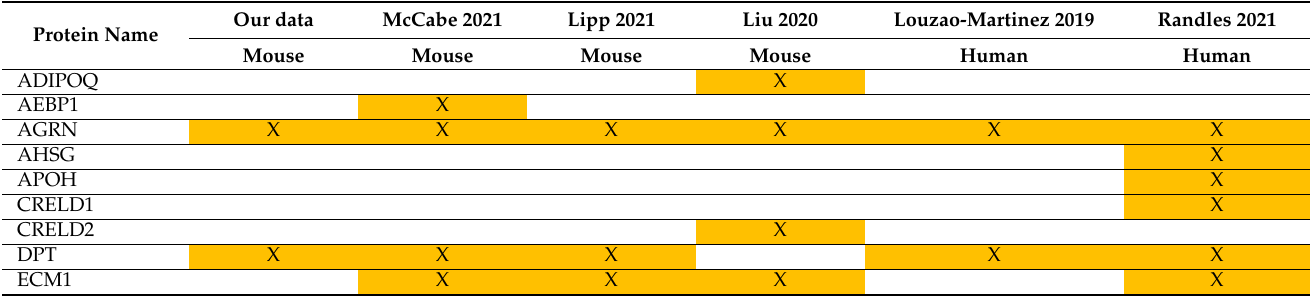
Table A11. The combined list of core matrisome proteins belonging to the category of ECM glycopro- teins and identified in mouse and human kidneys. The mouse matrisome proteins were obtained from our data and extracted from references [20,28,30]. Human matrisome proteins were obtained from the studies [31,32]. Highlighted “X” refers to identified protein in the corresponding